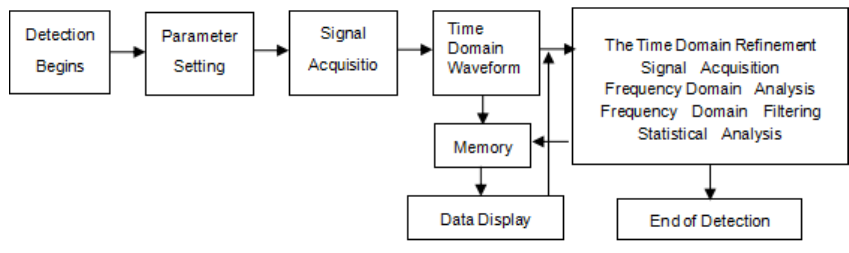
Fig. 3 System operation flow